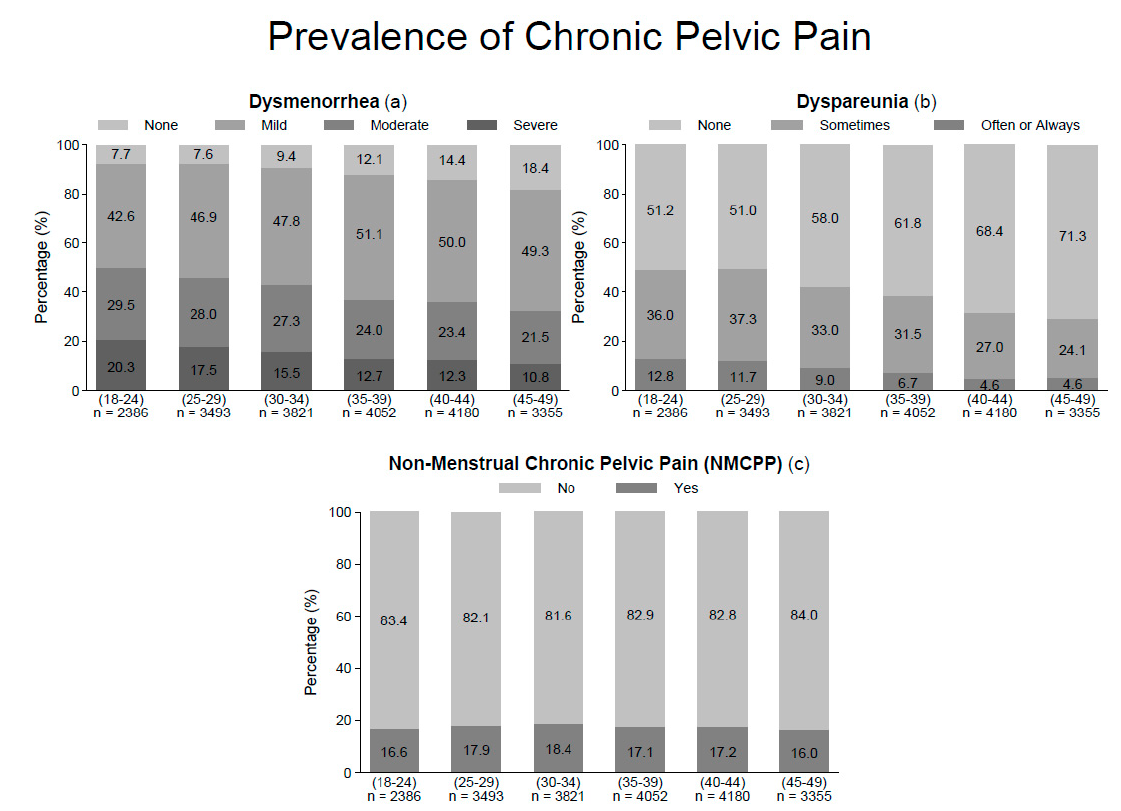
Figure 1. Prevalence of each type of chronic pelvic pain, n = 21,287. ( a ) Prevalence of dysmenorrhea (none/mild/moderate/severe), ( b ) Prevalence of dyspareunia (none/sometimes/often or always), ( c ) Prevalence of non-menstrual chronic pelvic pain (no/yes).